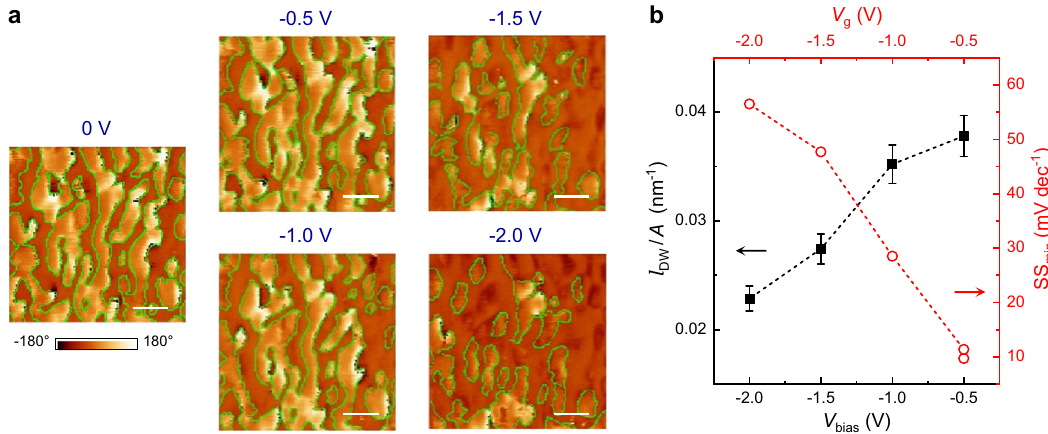
Fig. 5 Relation between DW density and SS. a L-PFM phase images of the same area in a 275 nm PZT fi lm taken at progressively higher DC V bias . The green lines mark the identi fi ed DW positions. Scale bars represent 100 nm. b l DW / A vs . V bias extracted from ( a ) (left-bottom axes) and SS min vs. V g -scan range taken on 2L MoS 2 FETs (right-top